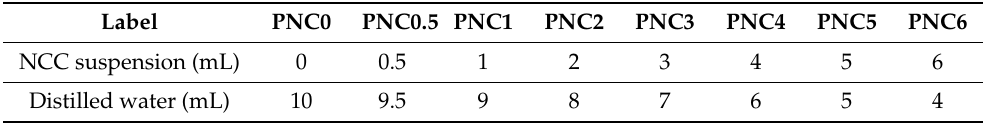
Table 1. The ratios of NCC suspension and distilled water